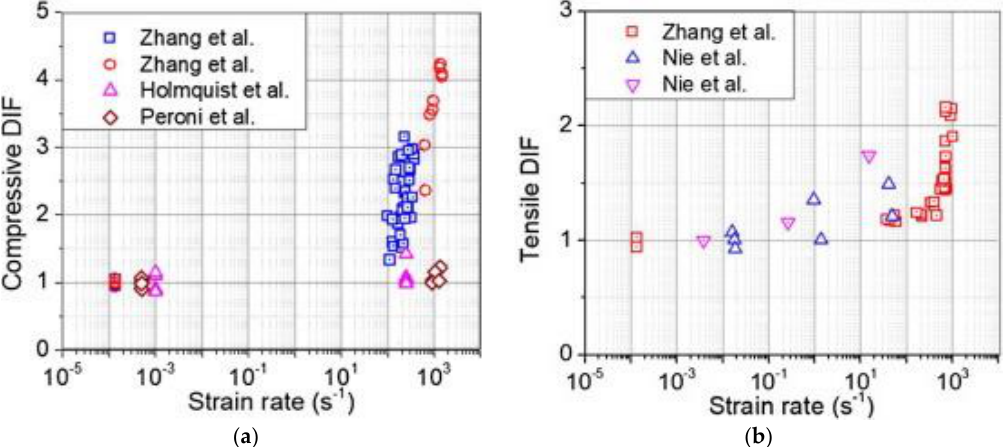
Figure 11. Reference Dynamic Increase Factor (DIF) for glass strength in ( a ) compression or ( b ) tension, as a function of the imposed strain rate. Figure reproduced from [2] with permission from Elsevier®, copyright license agreement n. 5041301127990 (April 2021).